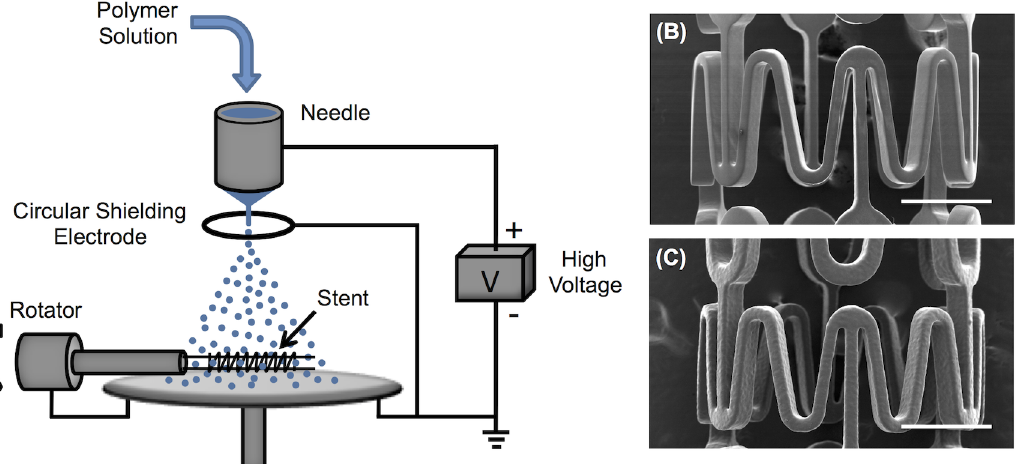
Fig 1. An electrospraying setup for stent-coating. (A) Schematic of an electrospraying setup for stent-coating using a circular shielding electrode placed right underneath the needle and above the aluminum plate. Continuous coating on Express coronary stent was achieved by exposed to the electrospraying mist for 30 min: (B) bare metal stent and (C) coated stent. Scale bar: 500 μ